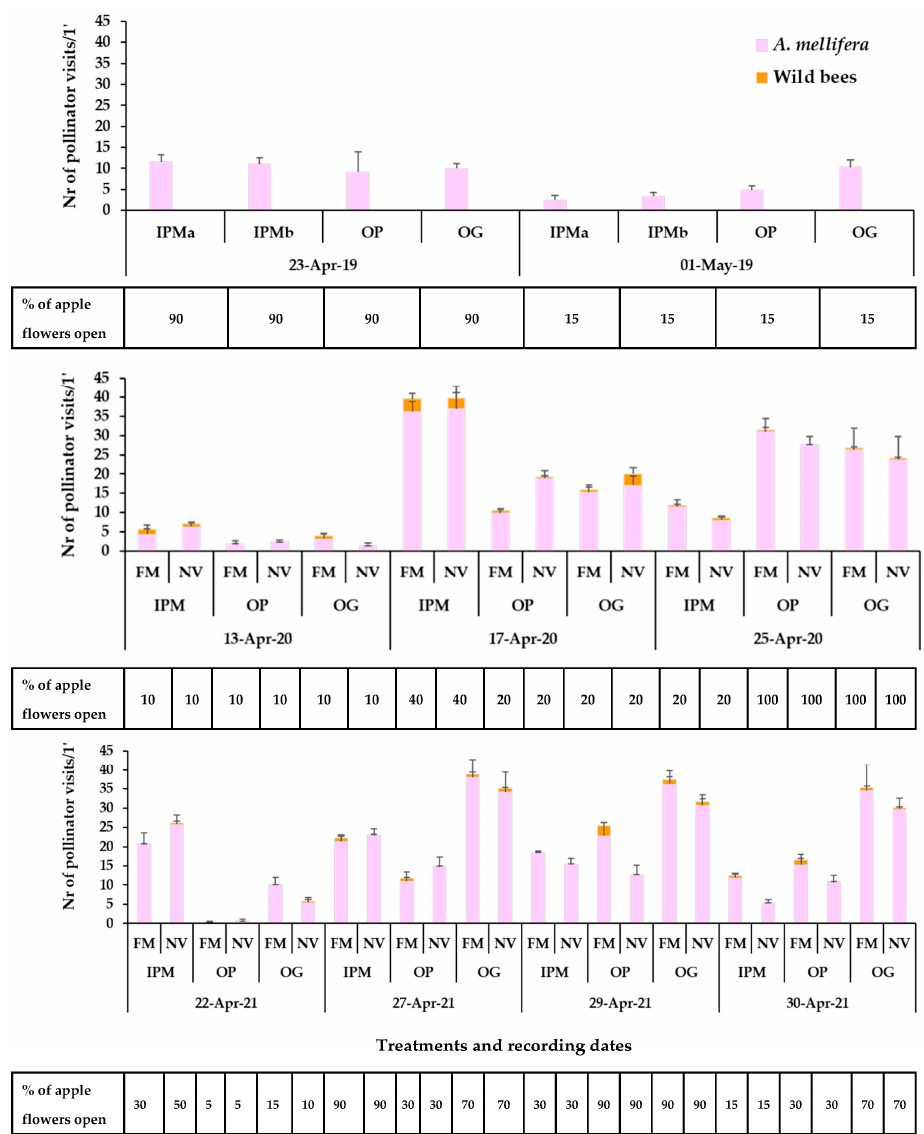
Figure 4. Mean numbers of Hymenoptera pollinator visits (honey bees, wild bees) on apple flowers recorded for 1 min/6.4 m 2 in the baseline year 2019, 2020, 2021. The horizontal bar below each graph represents the percentage of apple flowers open in each plot. IPM: IPM orchard with site (a) and (b) for the baseline year, OP: organic palmette orchard, OG: organic goblet orchard, FM: sown flowering mixture; NV: natural vegetation (wild plants). Vertical bars represent standard error of means.